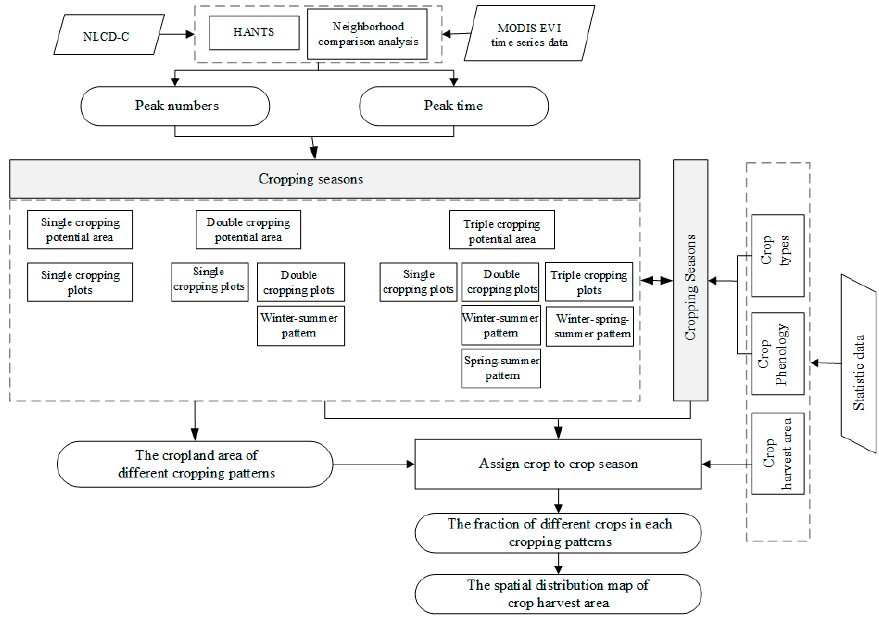
Figure 2. Workflow schematic for mapping crop distribution based on remote-sensing-derived cropping seasons and a regional crop calendar. Note: EVI, enhanced vegetation index; HANTS, harmonic analysis of time series.